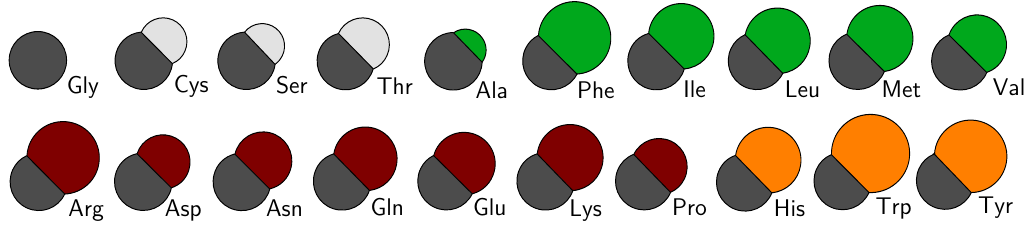
Figure 2. A schematic overview of all the residue types used in the CG protein model. The sizes of all particles are proportional with respect to each other. All residues (except for Gly) can be assigned to any of the four groups (as discussed in the text): the neutral group (Cys, Ser, Thr), the apolar group (Ala, Phe, Ile, Leu, Met, Val), the polar group (Arg, Asp, Asn, Gln, Glu, Lys, Pro), and the aromatic group (His, Trp, Tyr). Each of these groups is indicated by a different